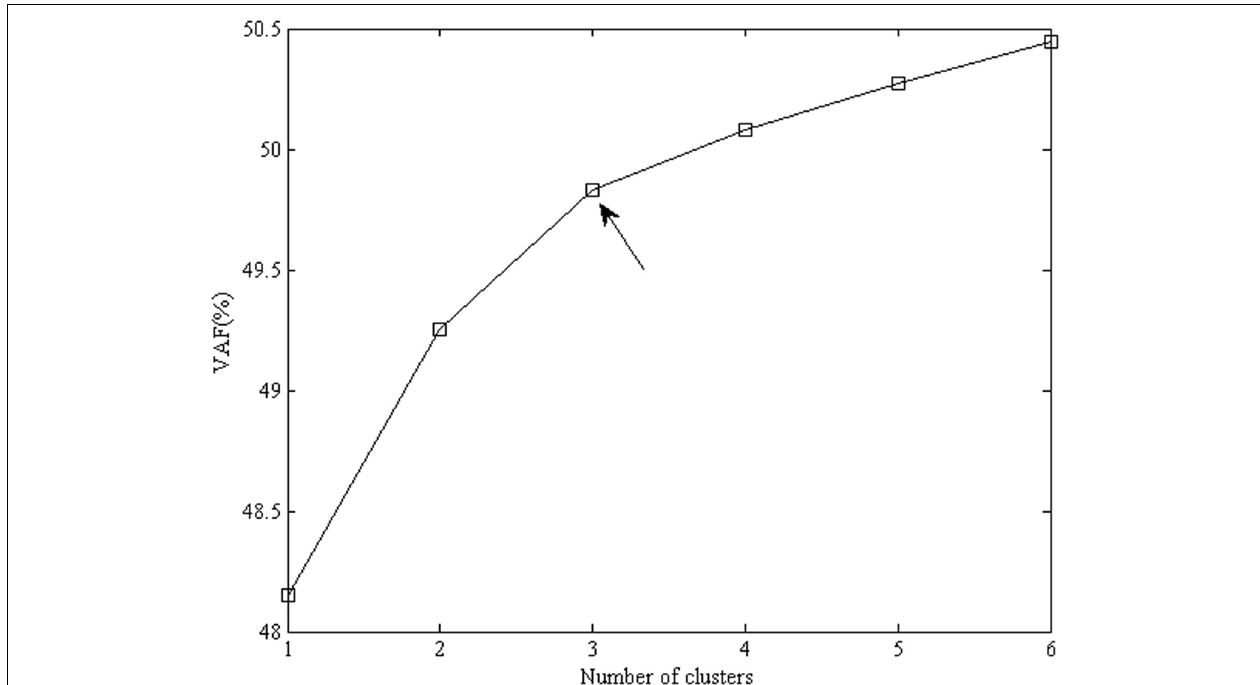
FIGURE 1 | Percentage of explained variance for clusterwise SCA-P solutions for the emotional acculturation data, with the number of components equal to 2 and the number of clusters varying